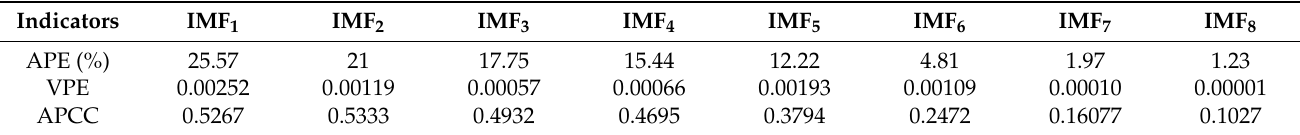
Table 5. Indexes related to the energy proportion of each IMF